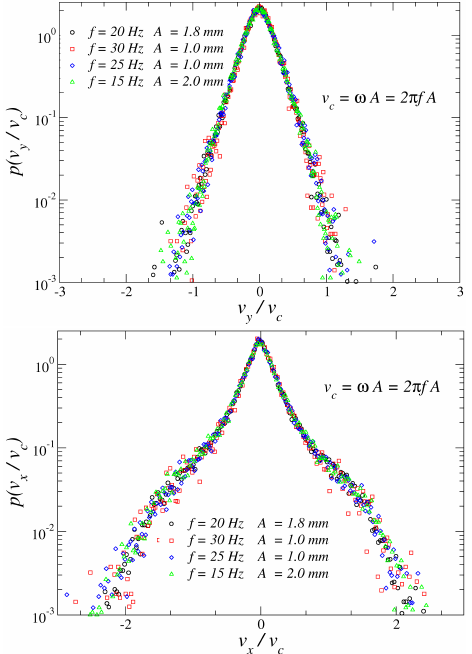
Figure 5. Scaled velocity distributions p ( v y /v c ) (top) and p ( v x /v c ) (bottom) for the indirectly and directly heated direc- tions, respectively. Data correspond to four di ff erent cases (two frequencies and two